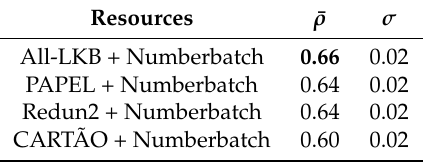
Table 17. Top Spearman correlations ( ρ ) for SimLex-999, based on the average of two different models.